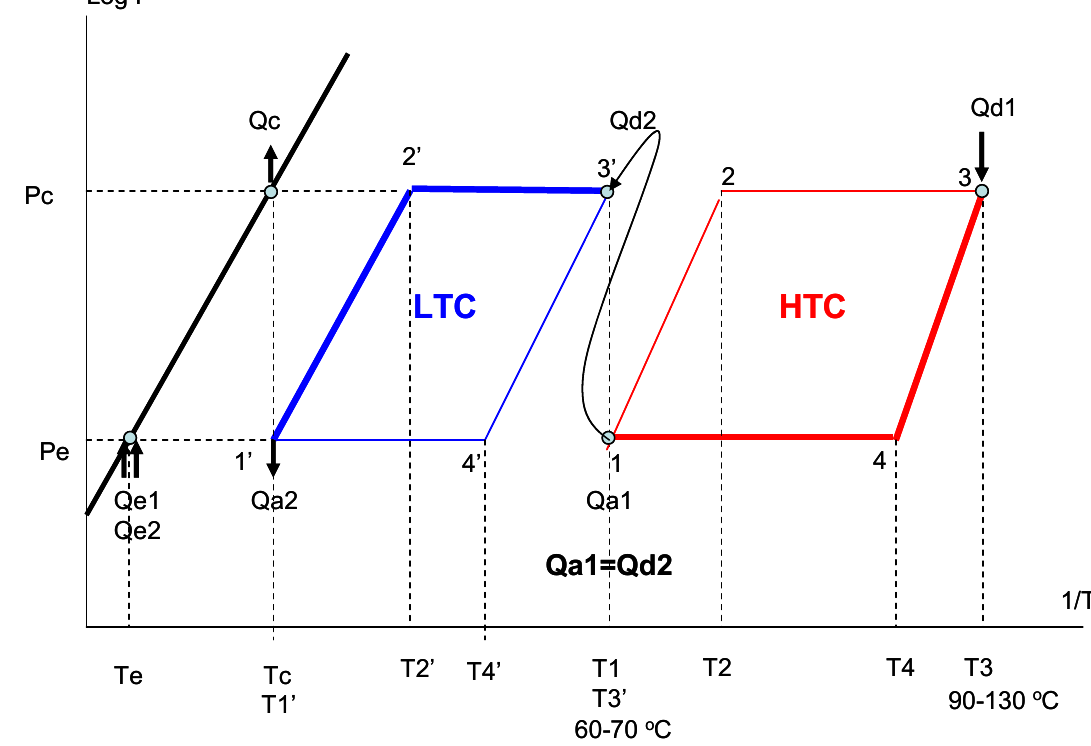
Figure 1. Ideal process of the cascading cycle without mass